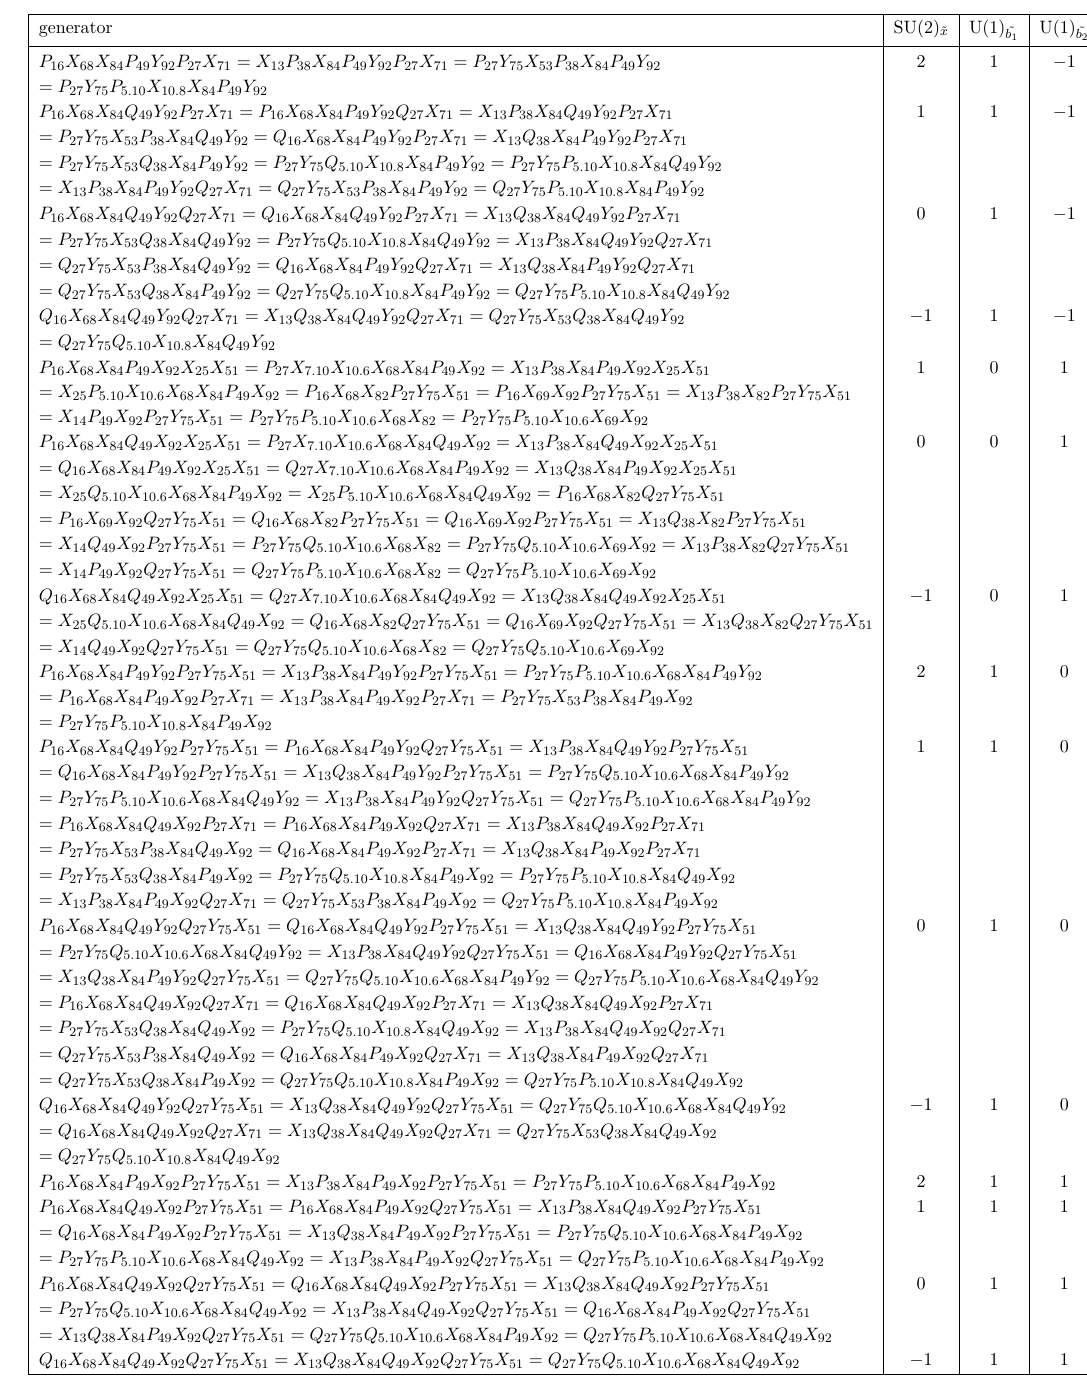
Table 58 . The generators in terms of bifundamental chiral fields for Model 14 (Part 2)